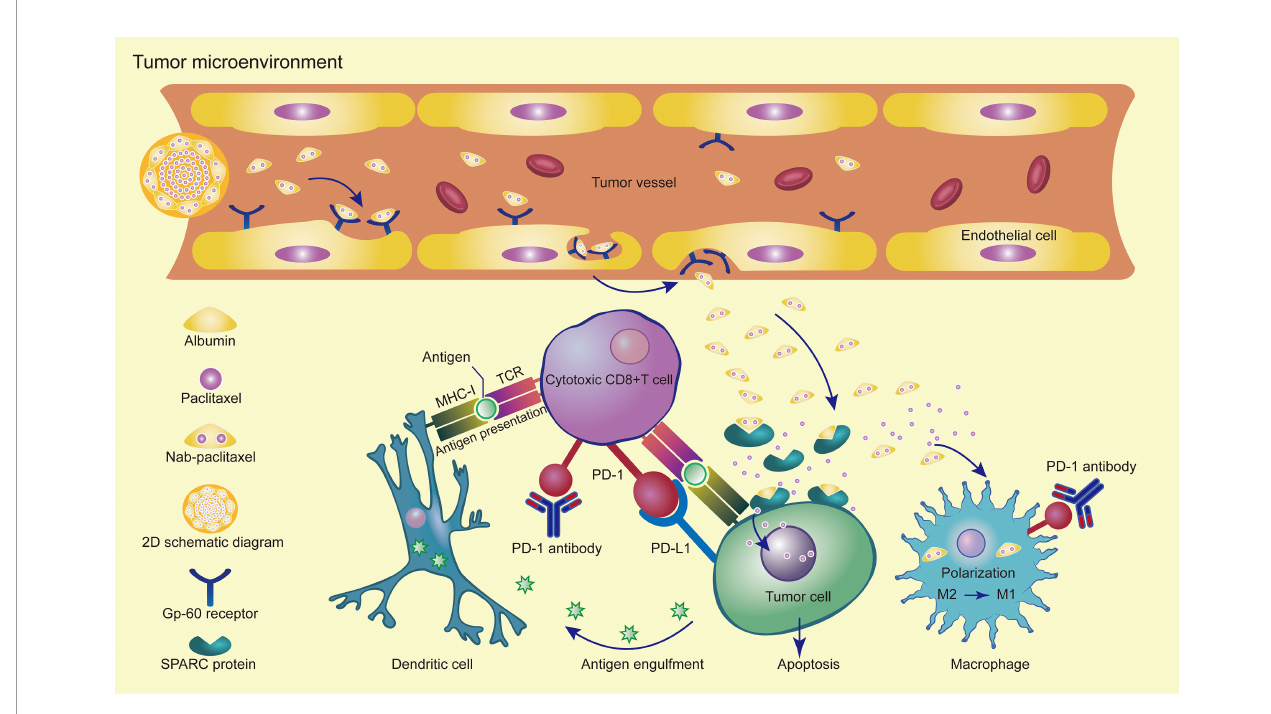
FIGURE 3 | Synergistic effects of PD-1 antibody in combination with nab-paclitaxel in the tumor